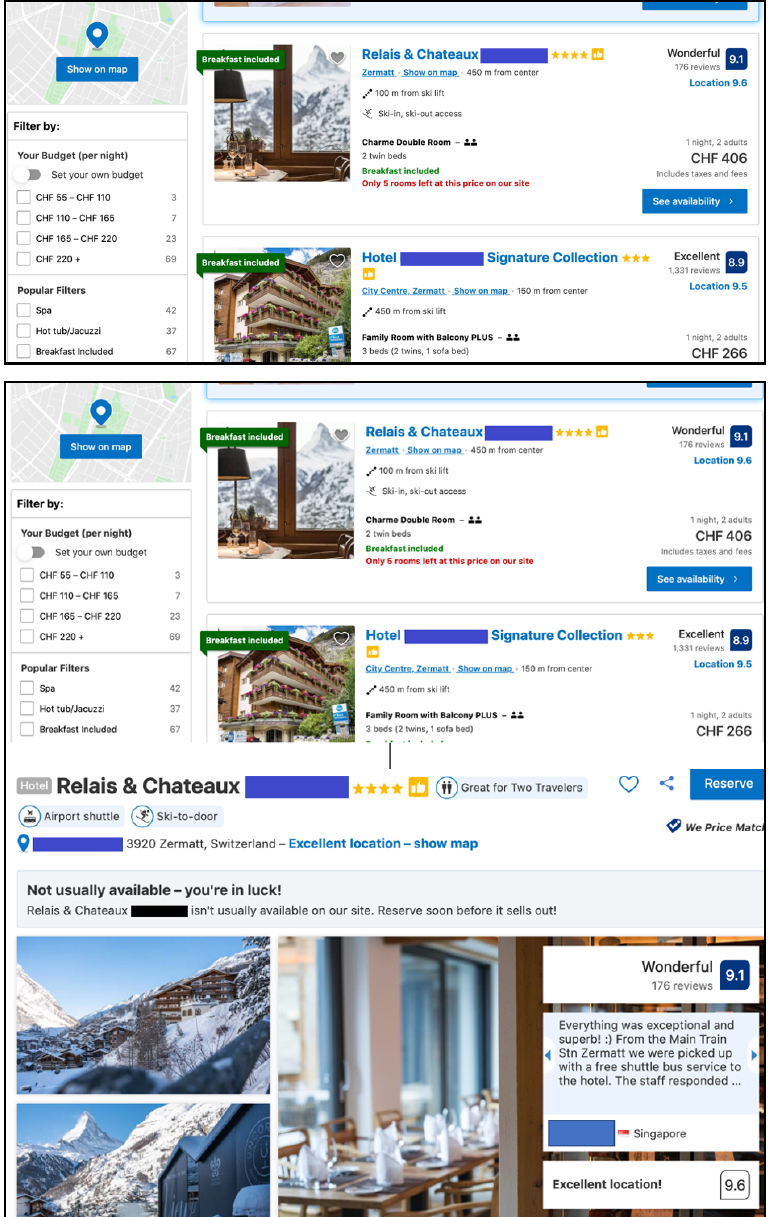
Figure 1. Example of search results (above) and hotel page (below) on Booking.com. Notes: Above on the left, some of the different fi lters that can be used to adapt search result list. On the list, review scores are prominently displayed. On the image below that, one can see the indication “great for two travelers”, the yellow thumb symbol that stands for the preferred partner program, and the highlighting of speci fi c